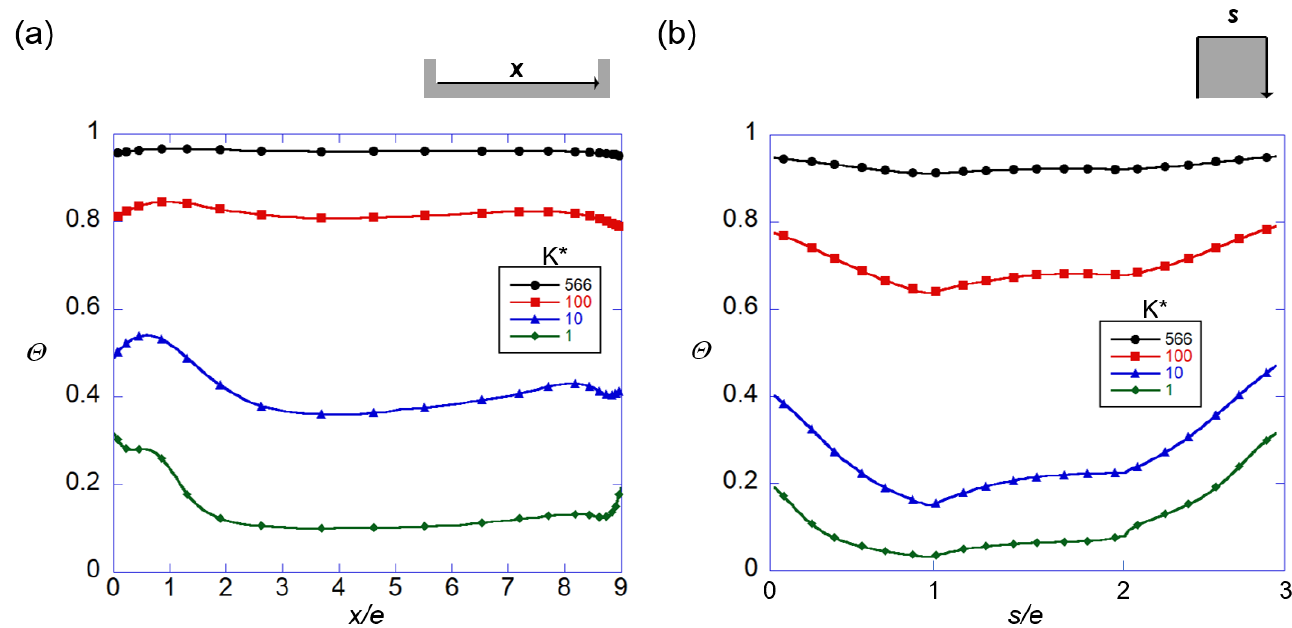
Figure 5. Local temperature distribution at the solid–fluid interface: ( a ) the temperature along the interface between the ribs and ( b ) the temperature on the rib.